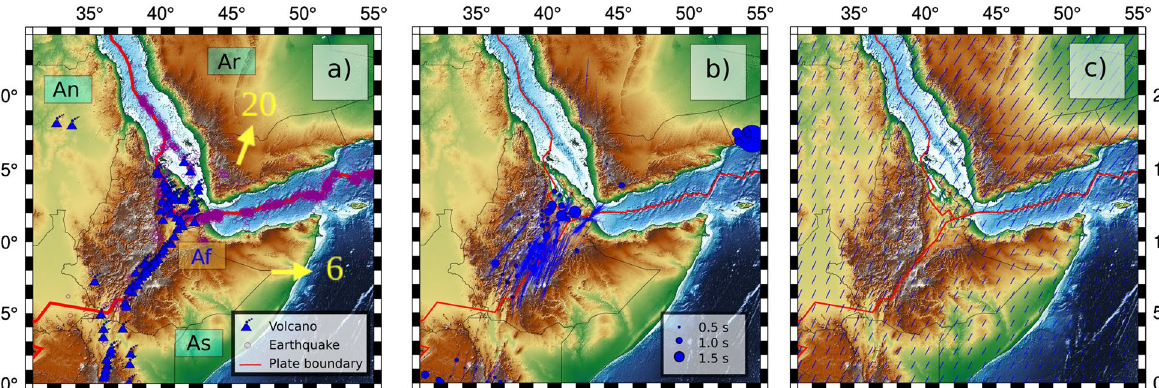
Figure 1. ( a ) Regional tectonic map of Afar region. Plate boundaries 1 are framed in red. The yellow arrows indicate the Absolute Plate Motion (in mm/year) with a European reference 49 . The location of the Holocene volcanoes 43 are highlighted with blue volcanoes shape. The location of the epicenters of earthquakes 50 is indicated with purple circles (Events depth displayed in Fig. S1). The black text framed in green provides the names of the different plates 1 : An, African (Nubian) plate; As, African (Somalian) plate; Ar, Arabian plate. The blue text framed in brown (Af) indicates the location of the Afar triple junction. ( b ) Shear-wave splitting measurements 29,30 . ( c ) GPS velocity field in a Eurasia-fixed reference frame 23 . Individual figure panels were generated with the Generic Mapping Tool (6.3.0) 51 and PyGMT (0.7.0) 52 . Individual figure panels were combined using Inkscape (1.2.1) 53 .